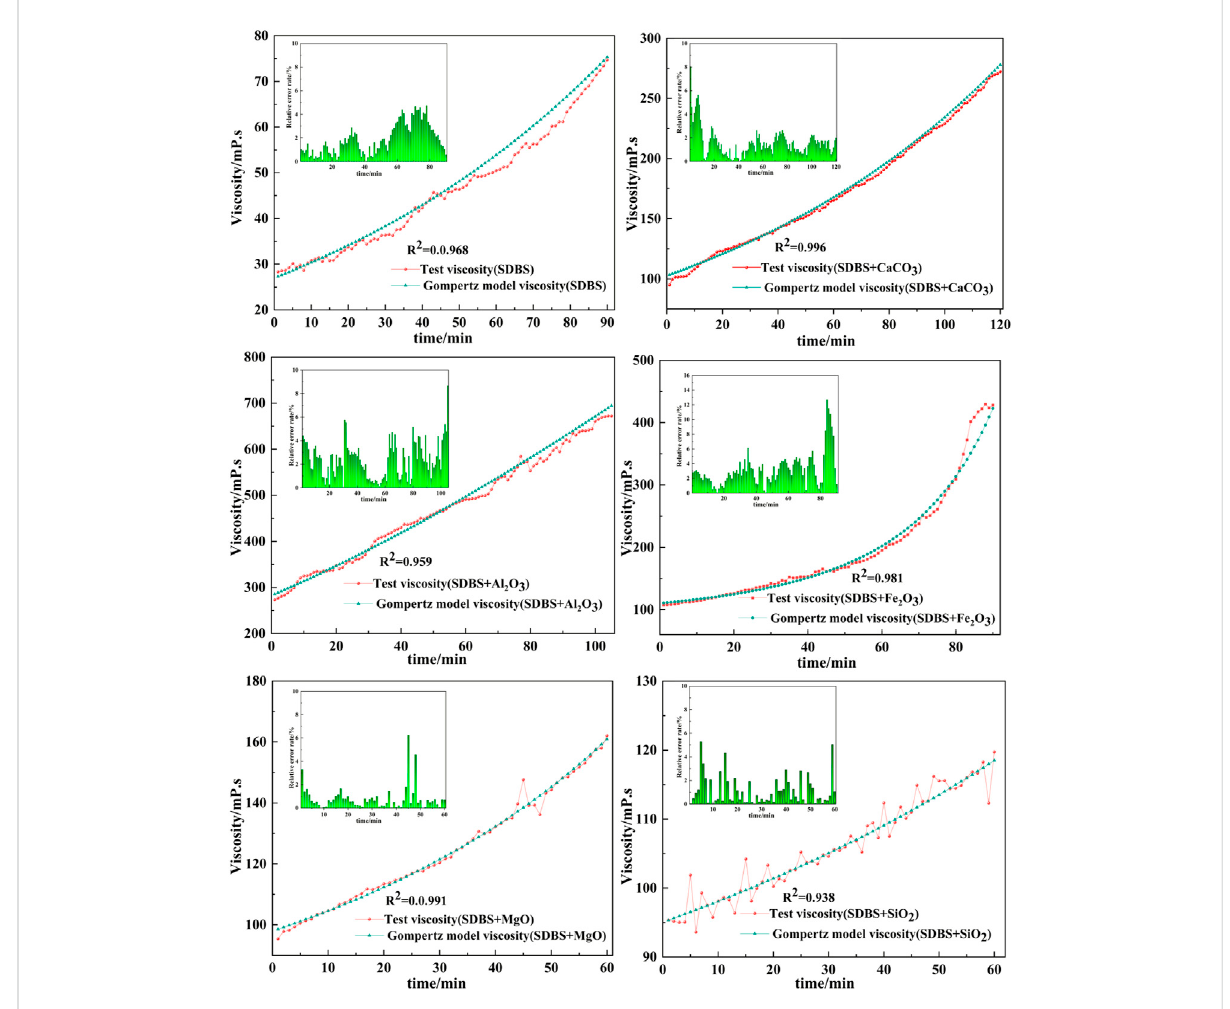
FIGURE 13 Fit of Gompertz model curves and experimental data for viscosity versus time for the SDBS emulsi fi ed asphalt mortars.